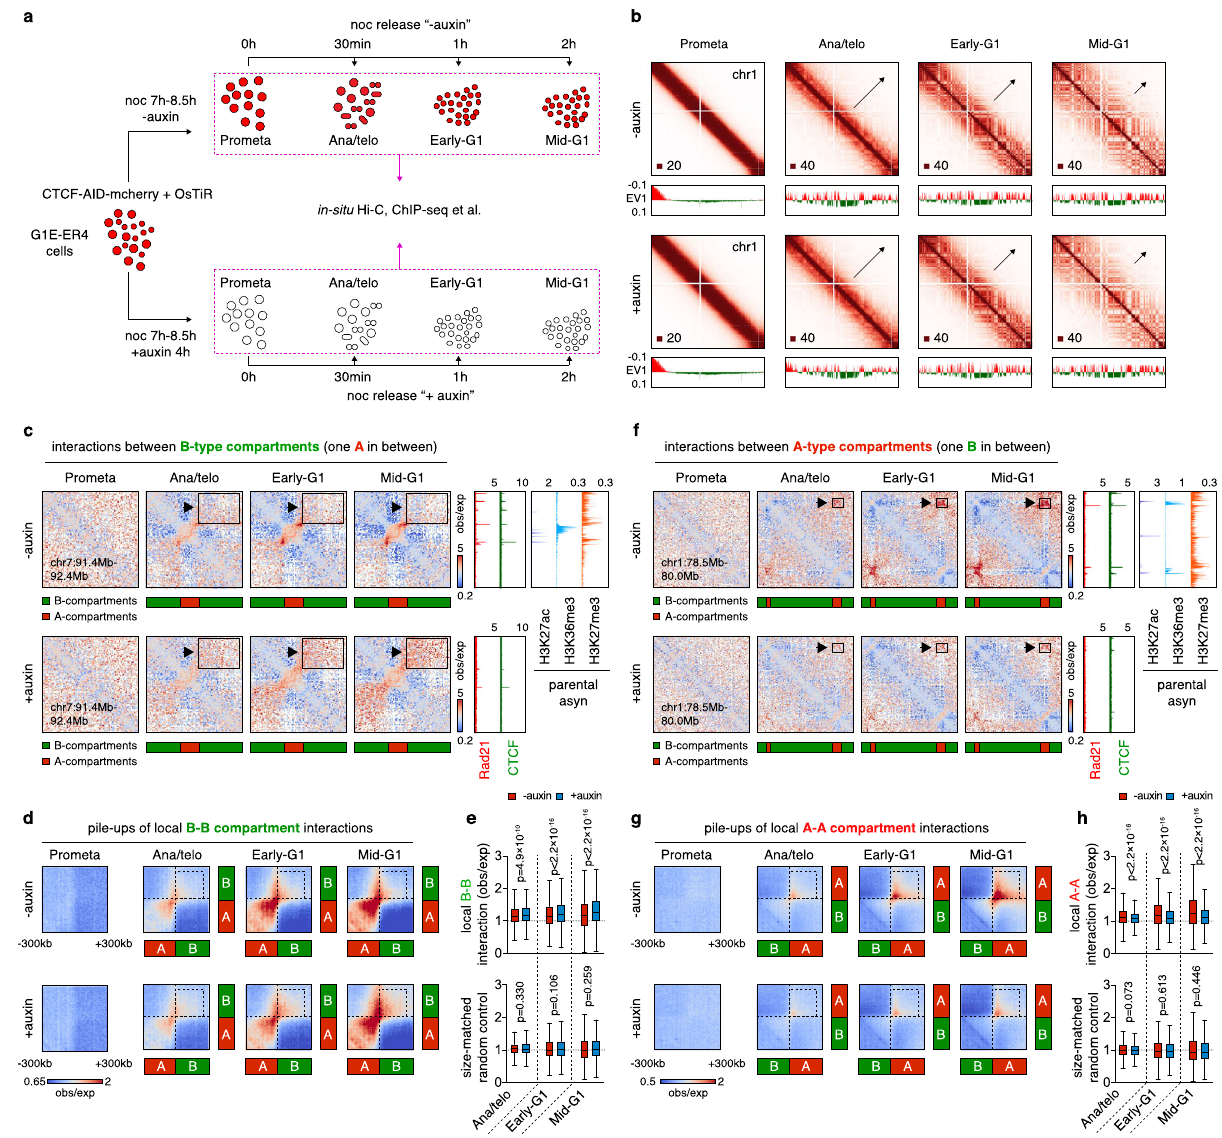
Fig. 1 Alteration of local compartmentalization upon CTCF removal. a Strategy for harvesting mitotic and post-mitotic populations with or without CTCF. b KR balanced Hi-C contact matrices showing global compartment reformation of chr1 in untreated and auxin-treated cells after mitosis. Bin size: 100 kb. Black arrows indicate the progressive spreading of compartments throughout the entire chromosome. Browser tracks with compartment PC1 values are shown for each contact map. c KR balanced Hi-C contact matrices showing representative local B – B interaction changes with or without CTCF depletion after mitosis. Bin size: 10 kb. Arrows and boxes highlight the increased local B – B interactions after CTCF depletion across cell cycle stages. Tracks of CTCF and Rad21 with or without auxin treatment, as well as histone, marks H3K27ac, H3K36me3, and H27me3 are from asynchronous G1E-ER4 cells. d Pile-up Hi-C matrices showing the increased local interactions between all consecutive (with one A-type in between) B-type compartment domains. Bin size: 10 kb. Dotted boxes indicate the increased local B – B interactions genome-wide. e Upper panel: Boxplots showing quanti fi cation of interactions in the dotted boxes (250 kb × 250 kb) in ( d ) ( n = 1604 pairs of short-range B – B interactions). Lower panel: Boxplots showing the effect of CTCF depletion on the interactions between randomly selected genomic pairs ( n = 465) that are distance-matched to the upper panel. Boxplots present upper and lower quartiles with the centerline as the median. Whiskers denote 1.5 × interquartile range (IQR). P values were calculated using a two-sided paired Wilcoxon signed-rank test. f , g Similar to c and d , showing examples and pile-ups of local consecutive (with one B-type in between) A – A interactions genome-wide. h Upper panel: Boxplots showing quanti fi cation of interactions in the dotted boxes (250 kb × 250 kb) in ( g ) ( n = 1612 pairs of short-range A – A interactions). Lower panel: Boxplots showing the effect of CTCF depletion on the interactions between randomly selected genomic pairs ( n = 469) that are distance-matched to the upper panel. Boxplots present upper and lower quartiles with the centerline as the median. Whiskers denote 1.5 × interquartile range (IQR). P values were calculated using a two-sided paired Wilcoxon signed-rank displayed markedly lower CTCF/cohesin occupancy than cluster1 Fig. 4i). We further quanti fi ed chromatin state transitions by and 2 (Fig. 2b). Visual inspection suggested that cluster2 and 3 principal component analysis (PCA) using 10 kb binned boundaries are frequently located at transitions between regions H3K27me3 and H3K36me3 ChIP-seq signals across the ±50 kb enriched for the repressive histone mark H3K27me3 and the region of each boundary (Fig. 2c). We found that the extreme transcription elongation mark H3K36me3 (Supplementary (top or bottom 20%) PC1 projections reliably predicted